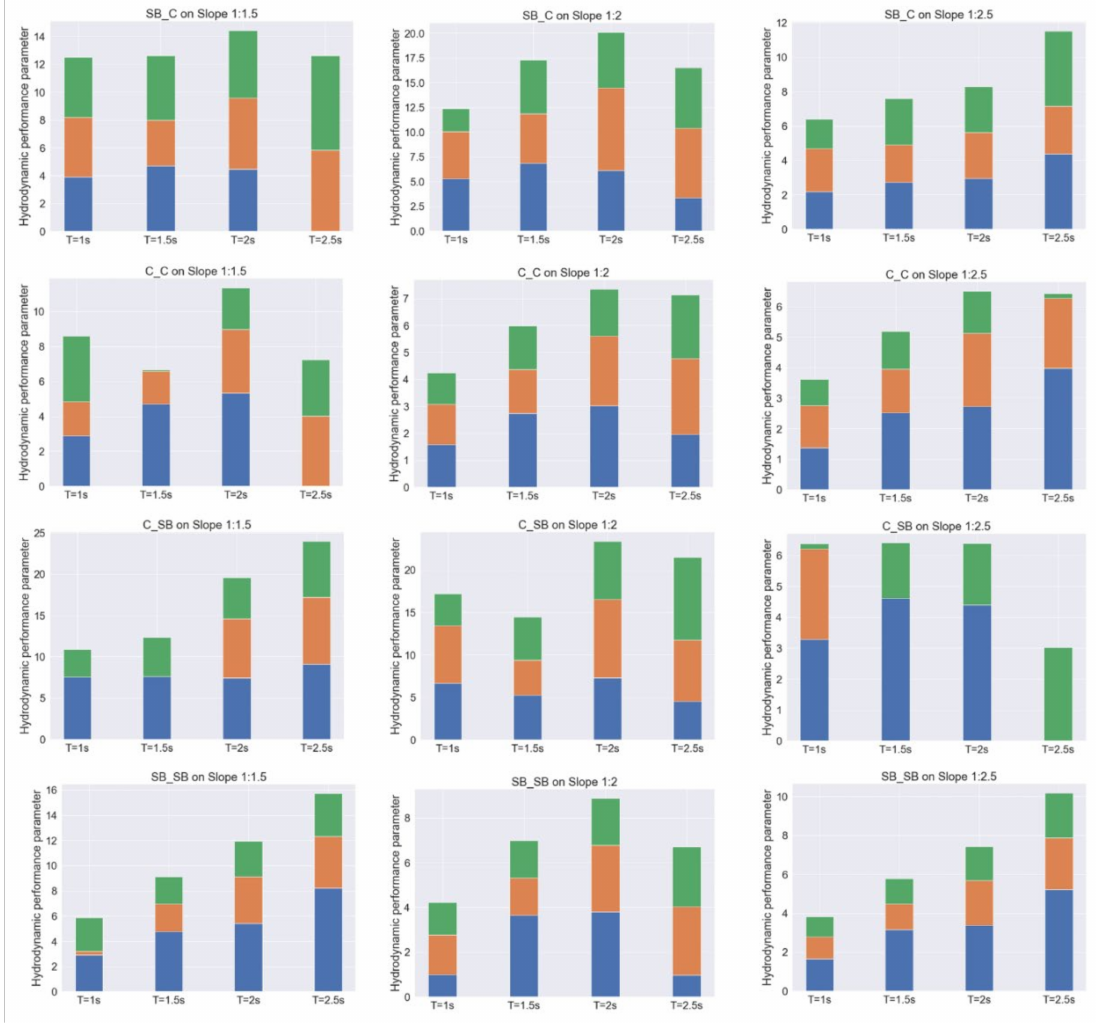
Figure 18. Hydrodynamic performance